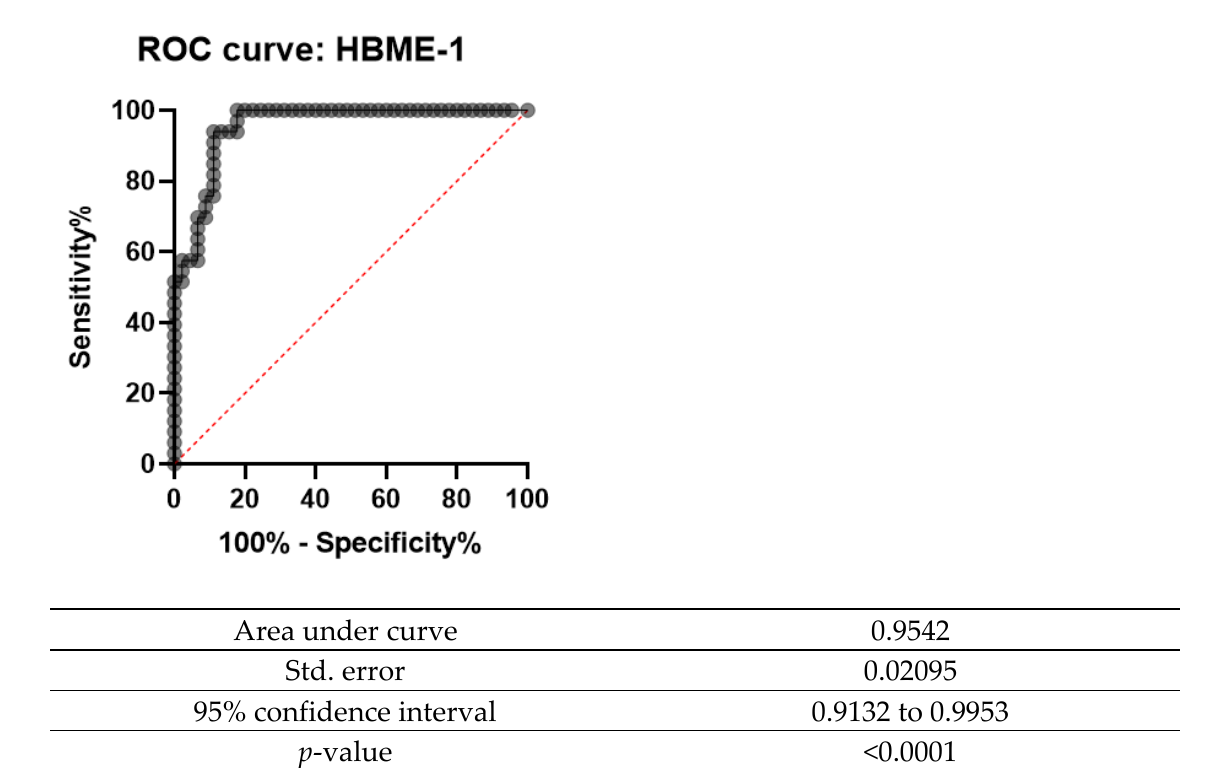
Figure 6. ROC curve for Gal-3 (2008 and 2013).